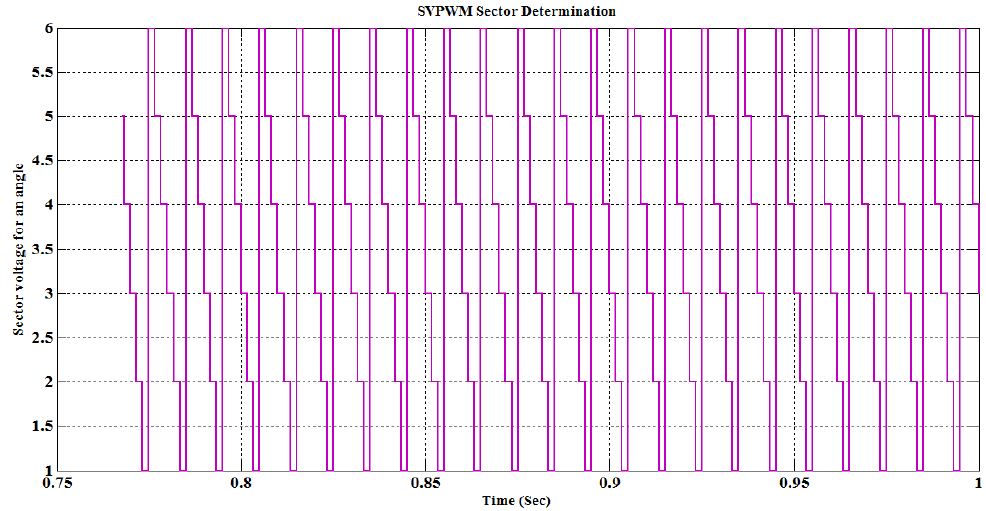
Figure 11. Voltage and current on the load side.